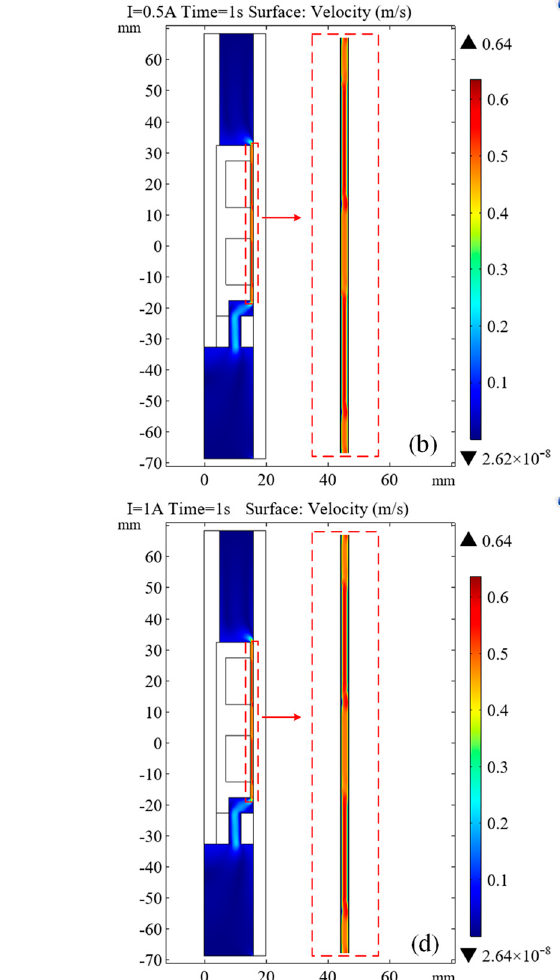
Figure 8. Velocity distribution for: ( a ) I = 0.25 A; ( b ) I = 0.5 A; ( c ) I = 0.75 A; and ( d ) I = 1 A.